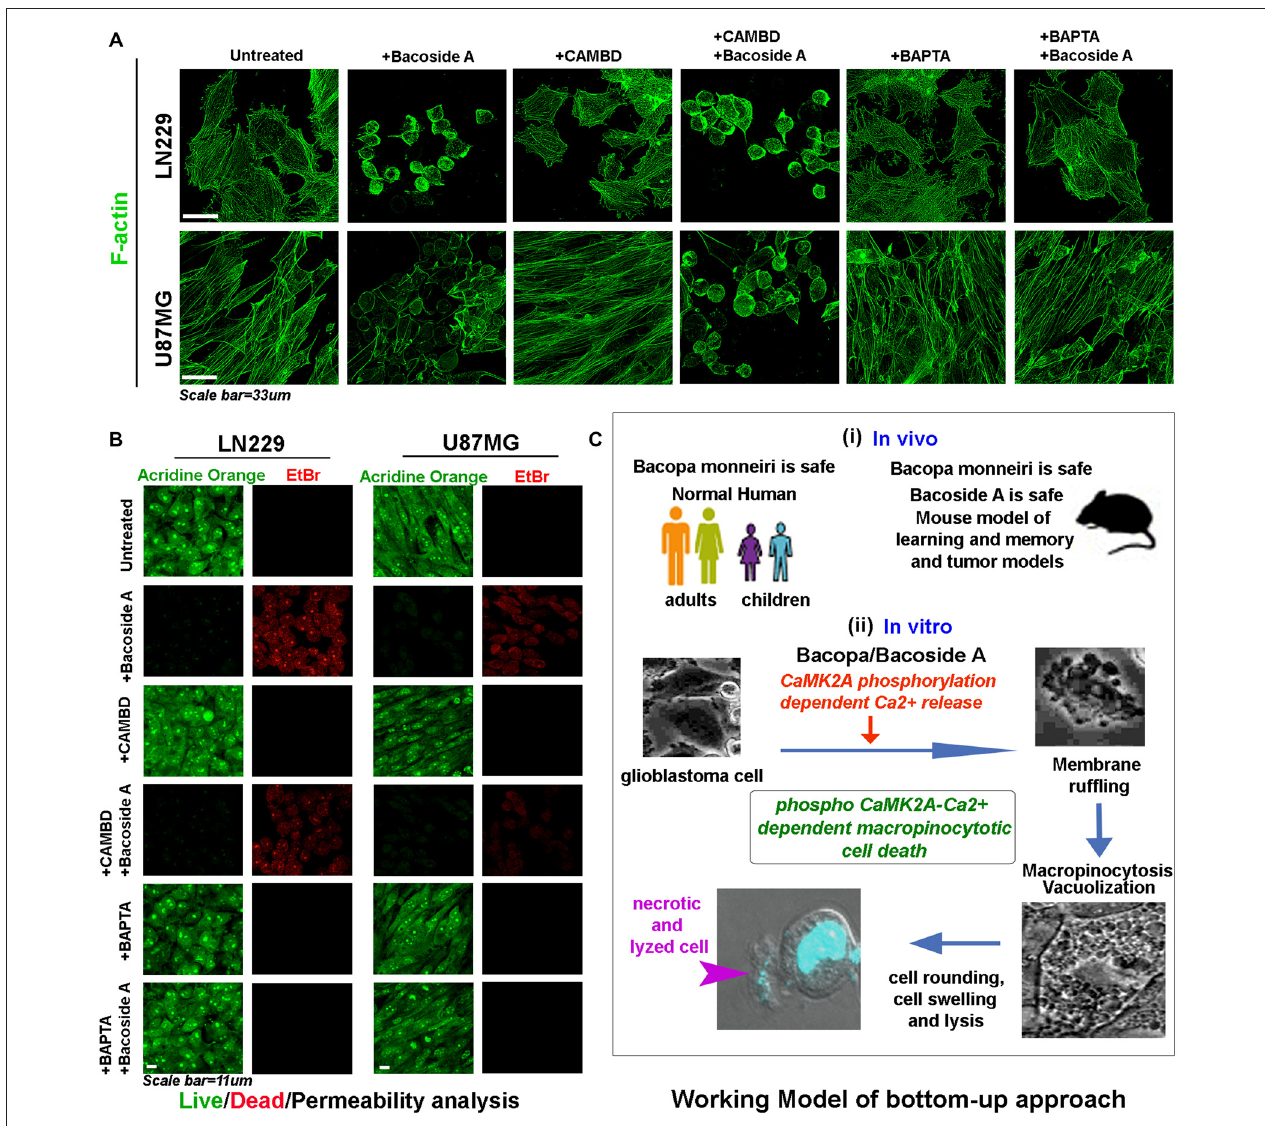
FIGURE 11 | Bacoside A mediated cell swelling and hydrostatic pressure changes results in cytoskeletal damage and increase in membrane permeability associated cell death. (A) Both LN229 and U87MG glioblastoma cell lines showed significant loss of cytoskeleton integrity upon Bacoside A treatment for 24–48 h, even in the presence of CAMBD but not when BAPTA, a calcium chelator was used, indicating that Bacoside A cytoskeletal damaging effects were dependent on intracellular calcium levels. As shown in Figure 10D , chelation of calcium dramatically reduces macropinocytosis and cell swelling, hence calcium induced excessive cell fluid uptake driven hydrostatic pressure in cells, ruptures the actin cables. (B) Acridine orange (green, live cell marker probe)/EtBr (red, damaged and dead cell marker dye) based cytotoxicity and viability analysis post 24 h Bacoside A treatment at 8 µ g/ml showed specific cytotoxic effects on LN229/U87MG/U251 glioblastoma cell lines even in presence of CAMBD but not when BAPTA, a calcium chelator was used, indicating that Bacoside A cytotoxic effects were dependent on intracellular calcium driven excessive fluid uptake and consequent build up of intense hydrostatic pressure that ruptures the plasma membrane. The analysis is representative of three independent experiments. (C) The conclusive working model of the study highlights a “bottom up approach”, wherein, BM, the anti-GBM potential target drug, is already demonstrated to be safe in both adult and children and its active component is additionally shown to be safe in normal mice and in tumor models. A further mechanism based in vitro study highlights a novel mechanism by which both Bacopa and Bacoside A may majorly work to enable GBM specific